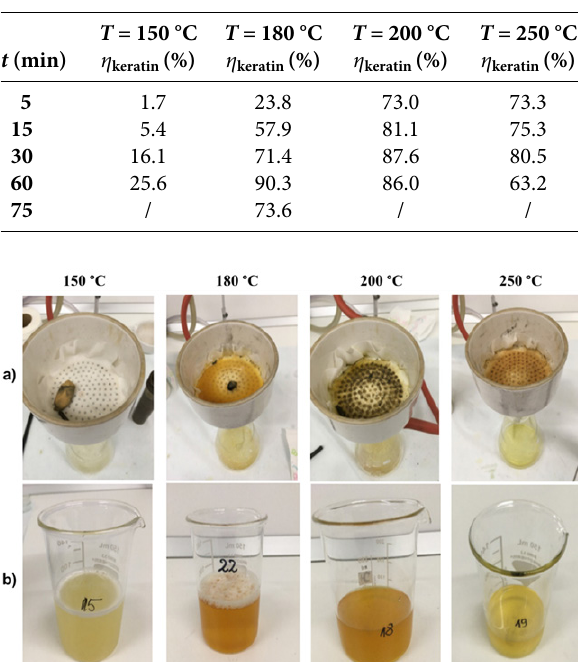
Table 3. Yield of extracted keratin from waste wool with SubCW.